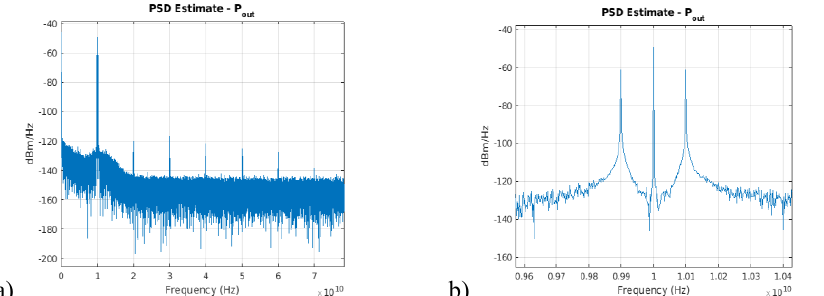
Fig. 6. Spectral density of the signal at the output of the photodetector during formation of modulated microwave signal: general view (a) and zoom view of the main mode (b).